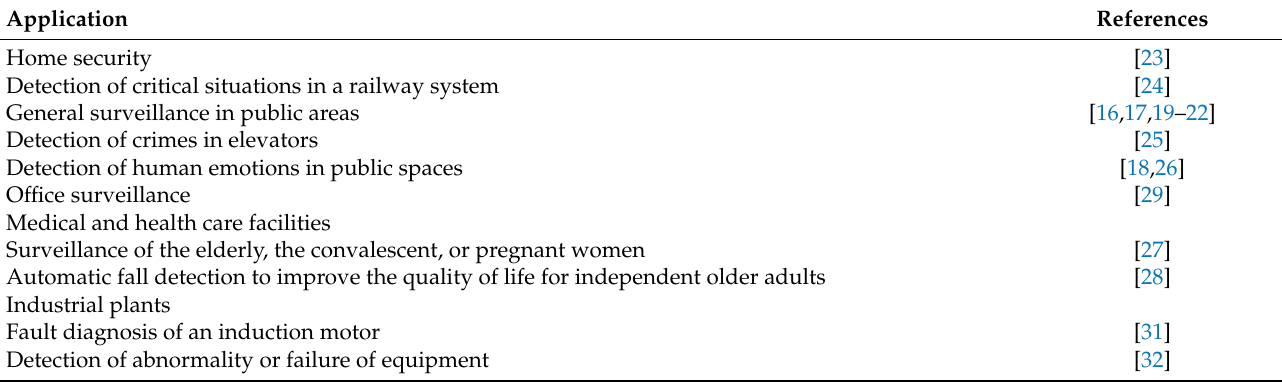
Table 3. Applications of sound